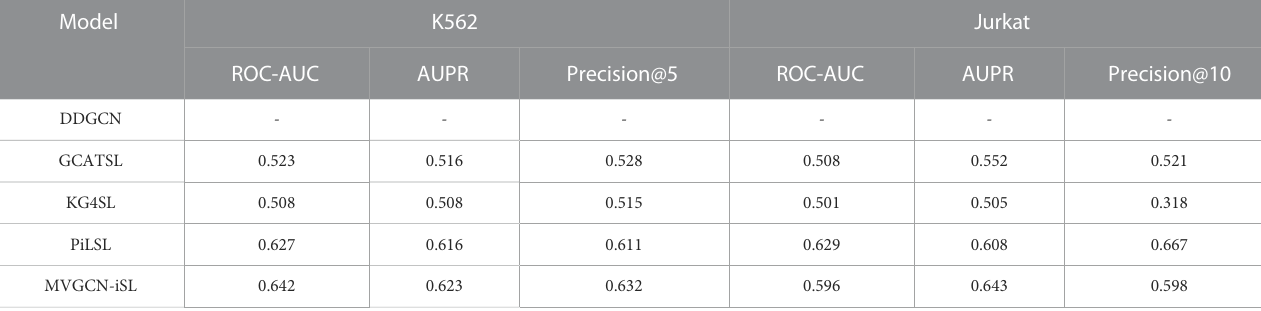
TABLE 3 Comparison with four GNN methods in two cell-speci fi c datasets under leave-gene-out evaluation setting.